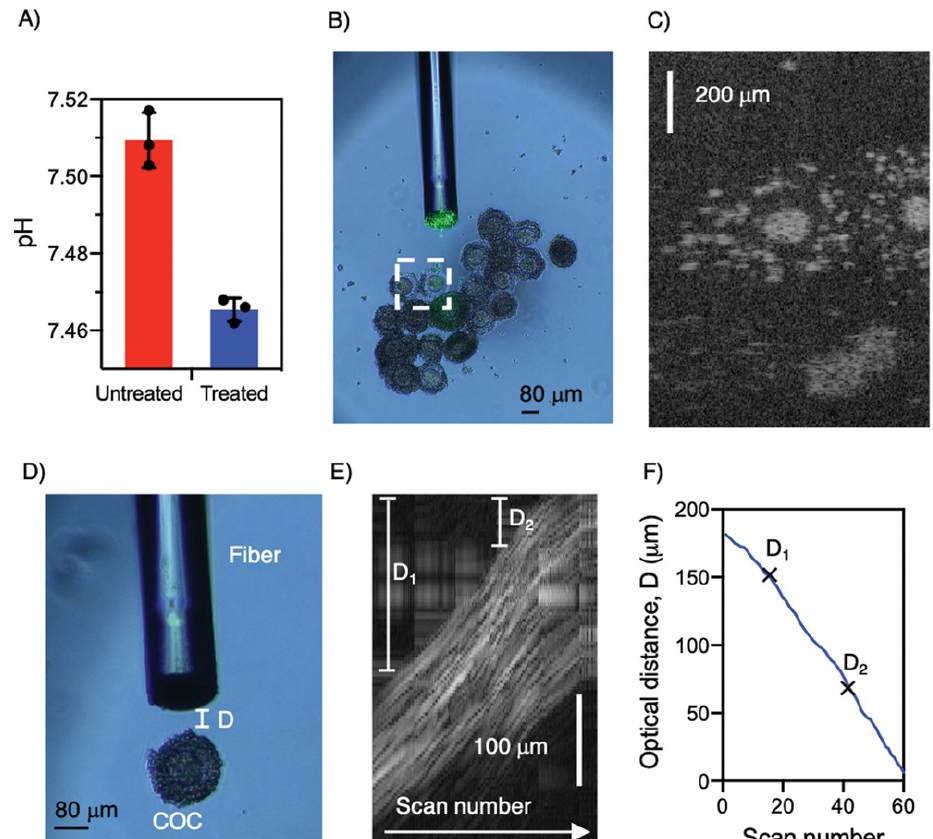
Figure 5. DCF-based OCT+pH probe for combined OCT and pH analysis of cumulus-oocyte complex. ( A ) pH measurements for untreated and COCl 2 treated oocytes. ( B ) OCT+pH probe near oocytes with OCT field of view in white box. ( C ) OCT image of oocytes. ( D ) OCT+pH probe near single oocyte. ( E ) Composite OCT scan series of oocyte with decreasing optical distance D between probe and target. ( F ) Number of scans versus optical distance for composite image showcased in ( E ). Image reprinted with permissions from ref. [47]. Copyright 2021 Wiley-VCH